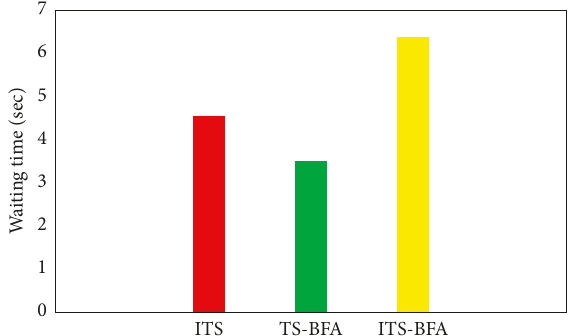
Figure 8: Average waiting time for all scheduling